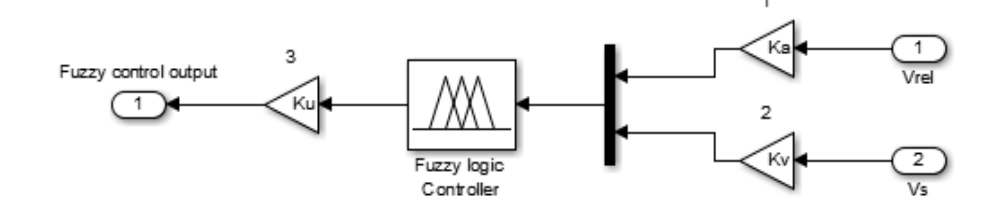
Figure 13. Structure of the fuzzy controller